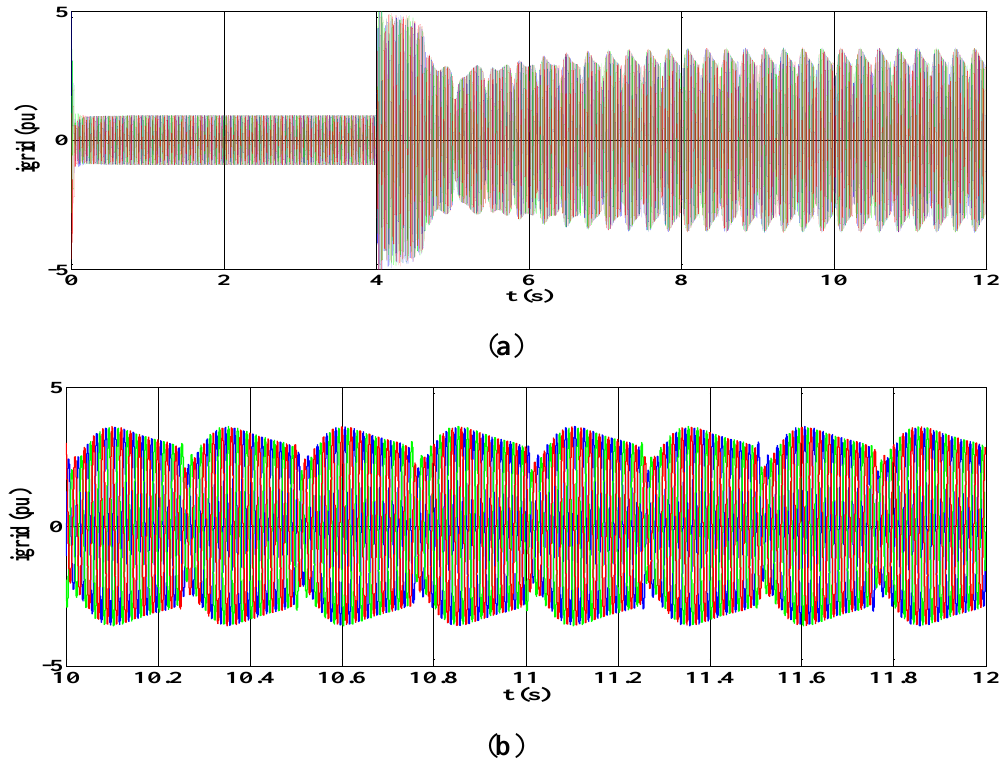
Figure 29. ( a ) Grid line currents (short-circuit happens at t = 4 s), ( b ) zoom of